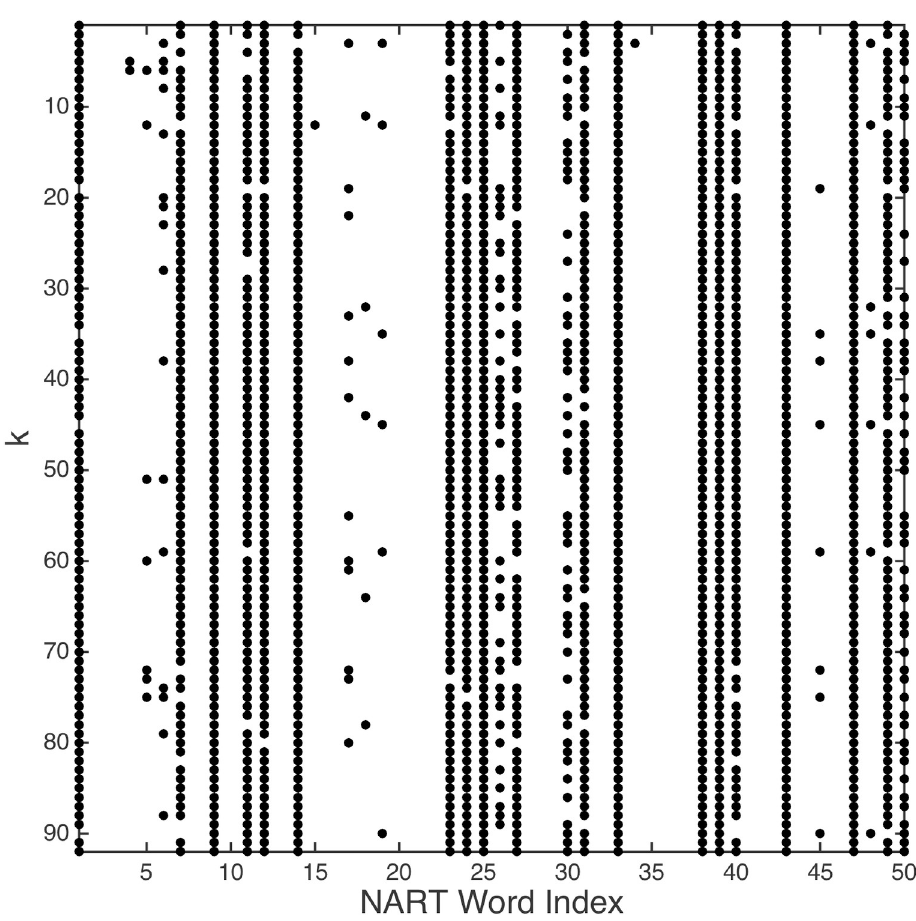
Fig 5. Chromosomes for n jackknifed GA models in which participant k was left out.